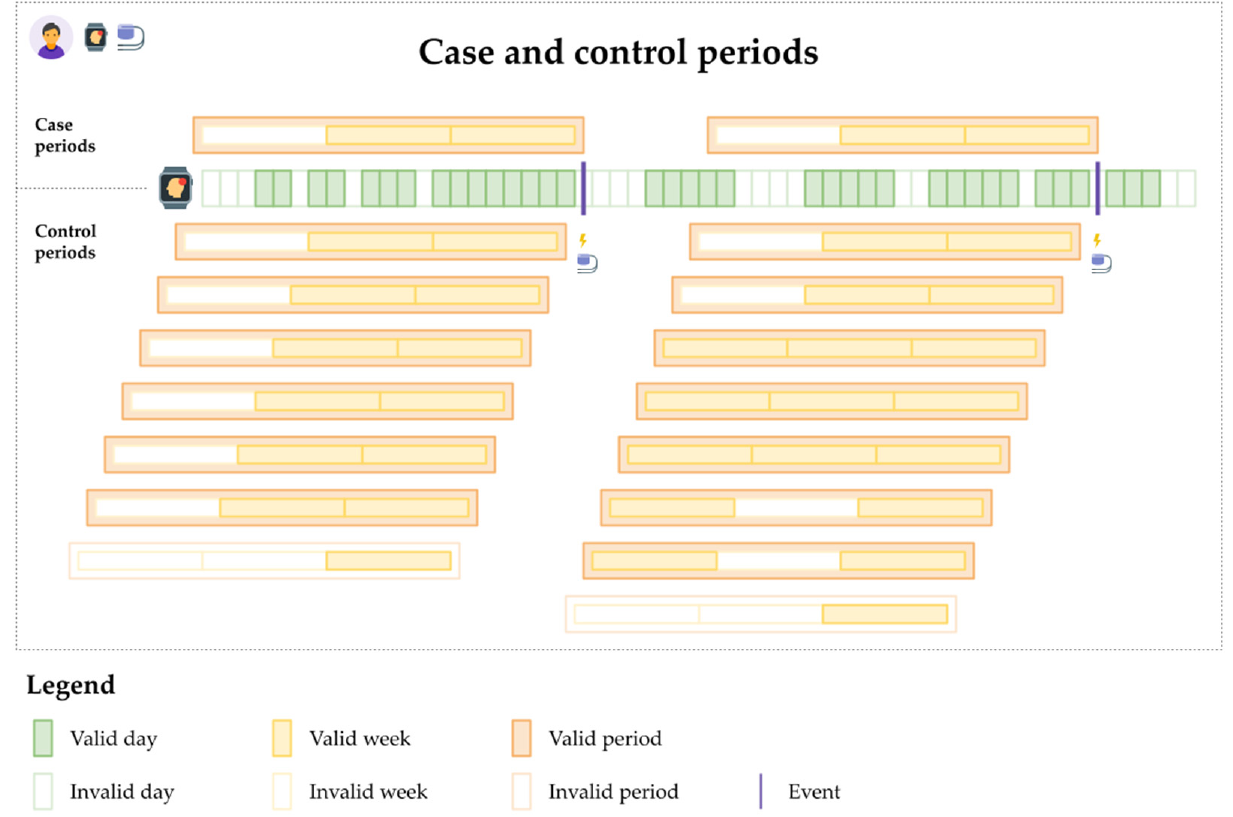
Figure 3. Case-crossover analysis: case and control periods for a combination of scenarios: an arbitrary scenario for valid days, at least four valid days for valid weeks, and at least 50% valid weeks for valid periods. Periods (depicted with orange contour) contain valid weeks (depicted with strong yellow contour and fill) and invalid weeks (depicted with pale yellow contour only). Week validity depends on having at least four valid days (depicted with strong green contour and fill) and at most three invalid days (depicted with pale green contour only). Case periods are followed by an event on the next day (depicted by a magenta vertical line). Events on the following day do not follow control periods. Valid periods (depicted with strong orange contour and fill) are either case periods (above the timeline of wearable monitoring) or control periods (below the timeline). Invalid periods are neither case periods nor control periods. The analysis uses all patients’ case and control